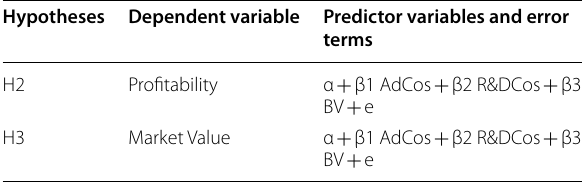
AdCos is advertisement cost, R&DCos is R&D activities costs and BV is brand value